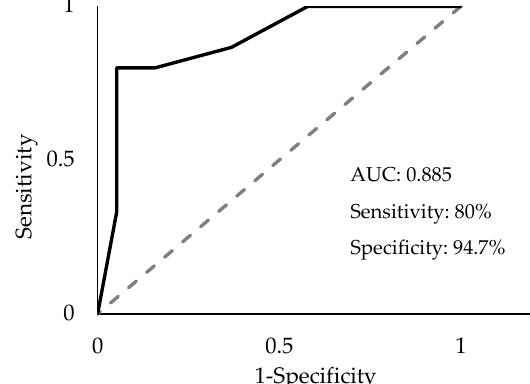
Figure 4. Receiver operator characteristic (ROC) area under the curve (AUC) analysis of the combined four-miRNA panel using two thresholds. Sensitivity = 80%, specificity = 94.7%; AUC = 0.885, CI99% 0.74-1.00, p < 1 × 10 −10 .